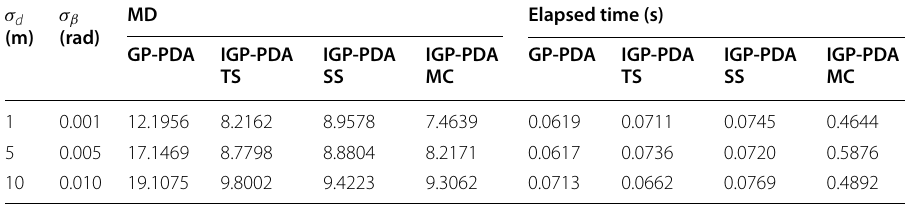
Table 4 Effect of measurement noise on contour estimates MD and Elapsed time in first scenario σ d σ β (m)